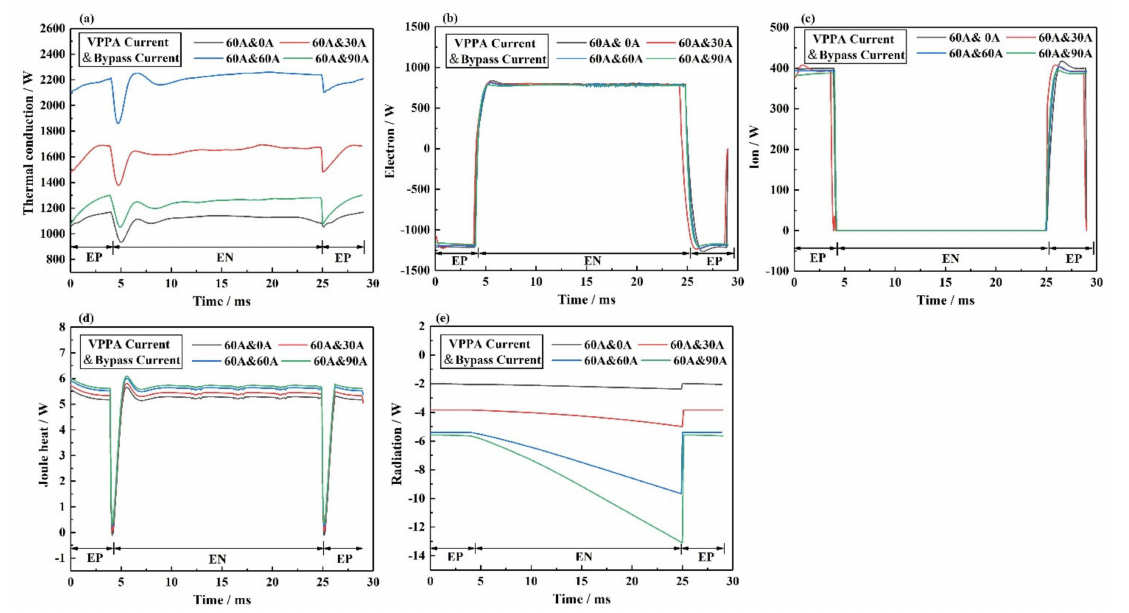
Figure 16. The energy transfer on the interface between bypass coupling plasma arc and base metal under different current conditions, including I v = 60 A and I b = 0 A, I v = 60 A and I b = 30 A, I v = 60 A and I b = 60 A, I v = 60 A and I b = 90 A, ( a ) thermal conduction, ( b ) electron, ( c ) ion, ( d ) joule heat, ( e ) radiation.